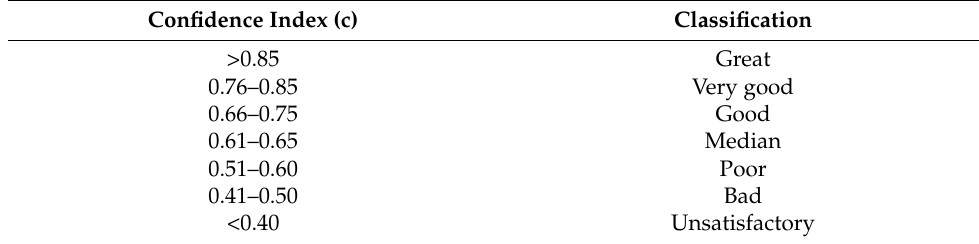
Table 4. Performance rating for the confidence index (c) [47].